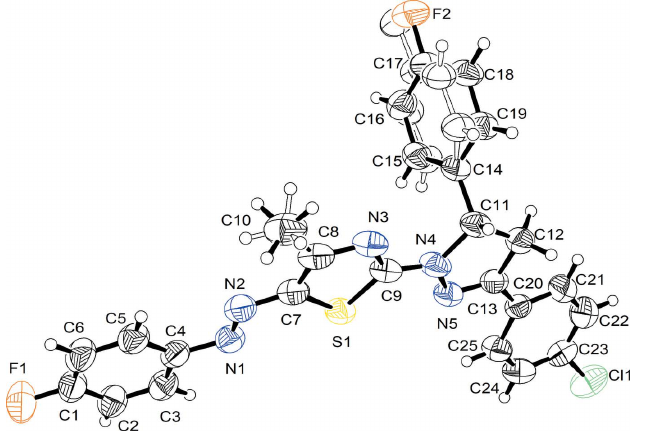
Figure 2 A segment of the crystal structure showing intermolecular contacts for the major component of the disordered structure.